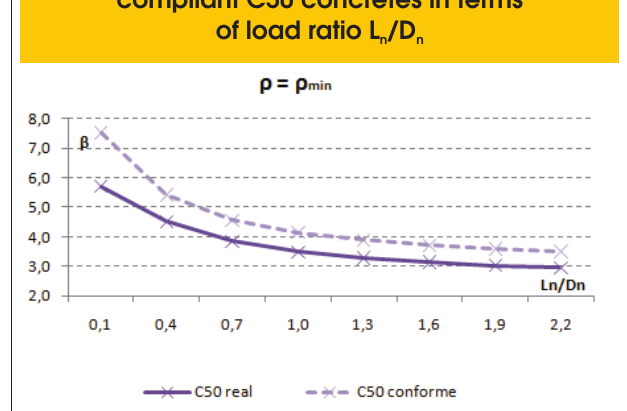
Figure 8 – Reliability index results for real and compliant C50 concretes in